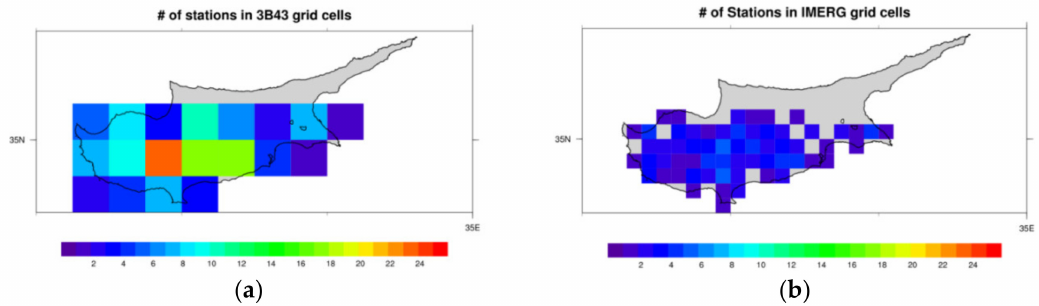
Figure 2. Distribution of rain gauge stations within Tropical Rainfall Measuring Mission (TRMM) 3B43 ( a ) and Integrated Multi-satellitE Retrievals (IMERG) ( b ) grids.